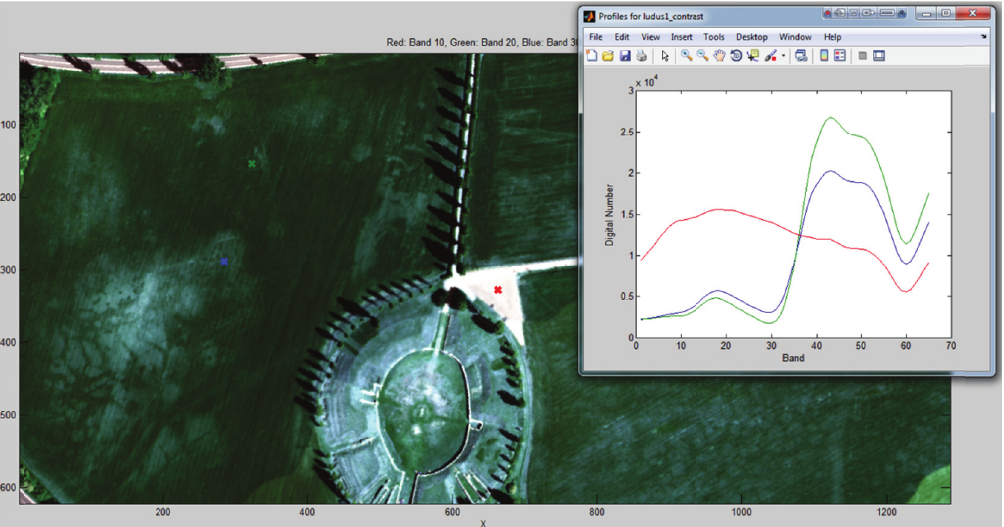
Figure 3. Investigating th he spectral profile